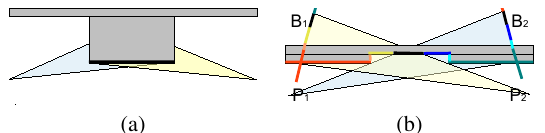
Figure 3. Occlusions caused by oblique view: a) Forward and backward recording geometry of a flat facade. b) Forward and backward recording geometry of a window. Caused by the oblique views both images show different parts of the window and the inner part is shifted in both images B1 and B2 The general setup of the texture generation allows the combina- tion of textures extracted from different sensors in the visible, near infrared, midwave thermal infrared and longwave thermal infrared. The combined analysis of textures from these spectral bands is still ongoing.